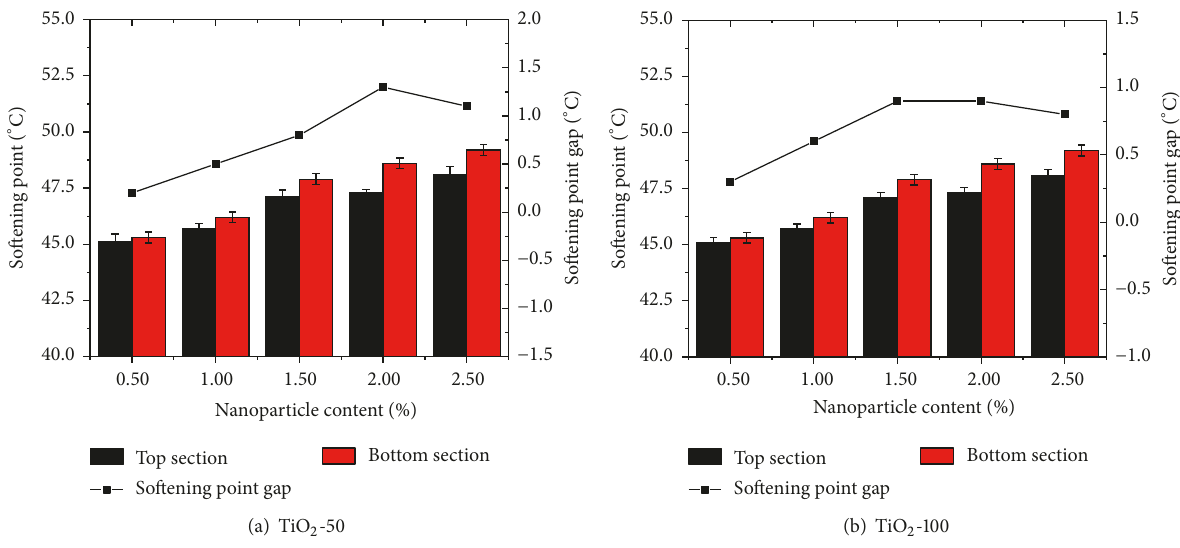
Figure 3: The effects of nanoparticle content on the softening